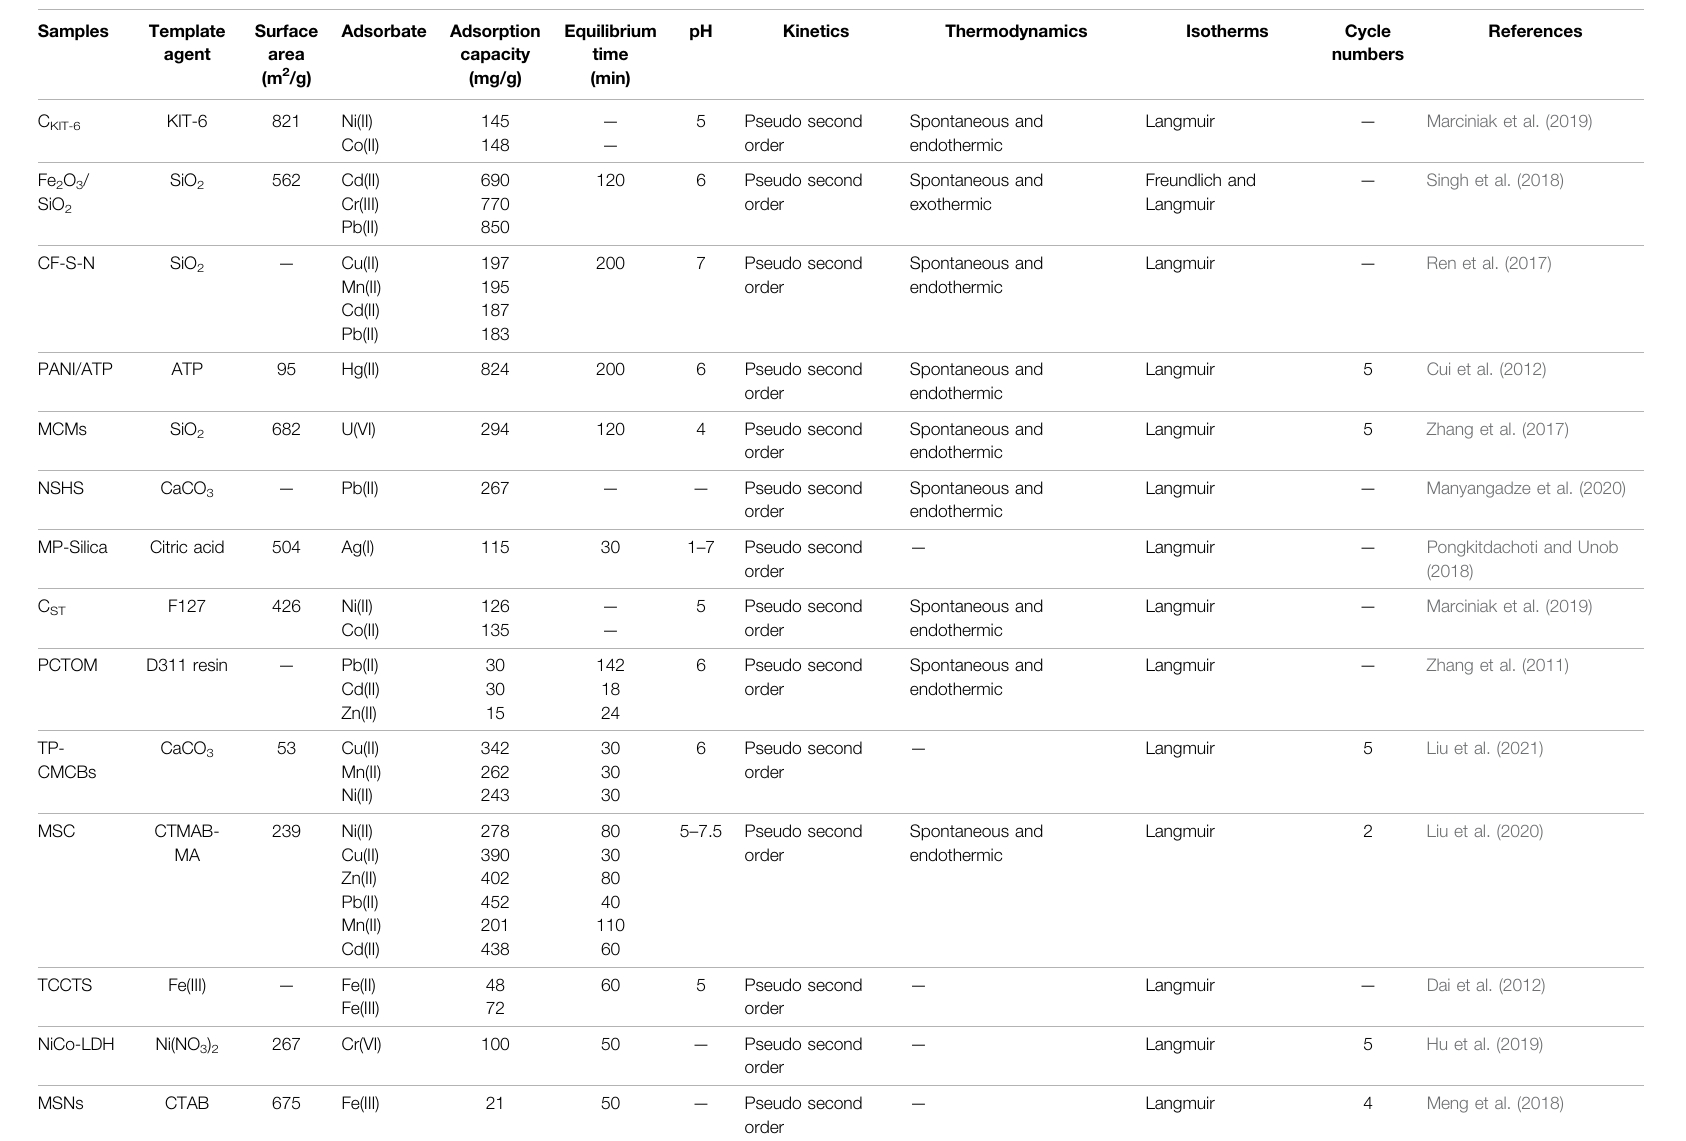
TABLE 3 | Properties of various template materials and their ability to adsorb heavy metals.